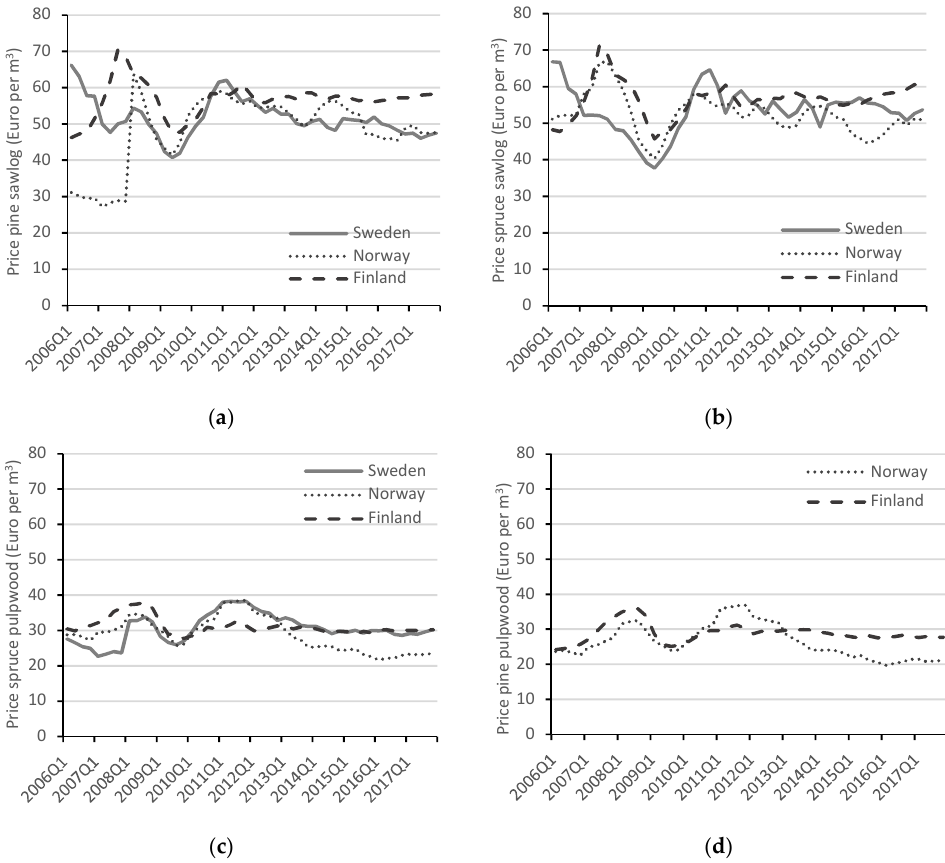
Figure 2. Nominal prices in Finland, Sweden and Norway between 2006 and 2018 (EUR per m 3 ) for ( a ) pine sawlogs, ( b ) spruce sawlogs, ( c ) spruce pulpwood and ( d ) pine pulpwood. Sources: [16–18].